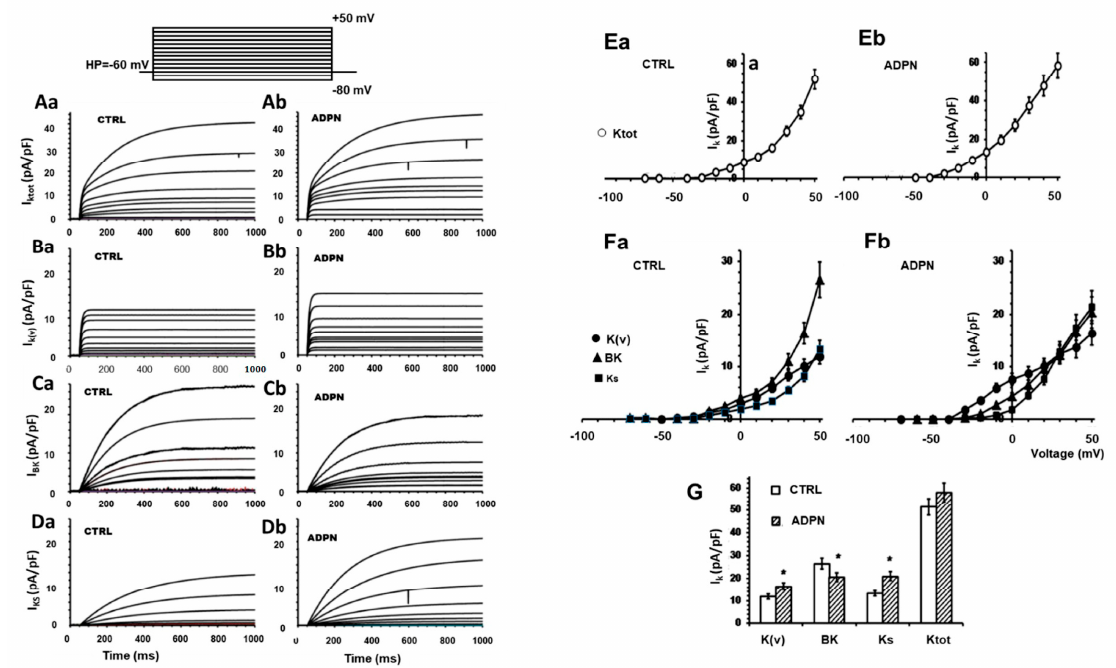
Figure 3. E ff ects of ADPN on the di ff erent voltage-dependent K + currents in an SMC from the gastric fundus. ( Aa , Ab )Total outward K + currents traces, elicited by voltage steps from − 80 to + 50 mV (holding potential (HP) = -60 mV) in nifedipine (10 µ M) containing solution, in control condition ( Aa ), and in the presence of ADPN 20 nM ( Ab ). Current values are normalized to cell capacitance. The pharmacological dissection allowed us to systematically distinguish three kinds of K + currents: IKv ( Ba , Bb ); IBK ( Ca , Cb ); and IKs ( Da , Db ). Current values are normalized to cell capacitance. ( Ea , Eb ) I–V plots related to IK,TOT in CTRL ( Ea ) and in the presence of ADPN ( Eb ). ( Fa , Eb ) I–V plots related to IKV, IBK, and IKs, in CTRL conditions ( Fa ) and in the presence of ADPN (Fb). The continuous lines through the experimental data represent the fitted Boltzmann function. Current values are normalized to cell capacitance. Statistical significance is not depicted in the figure for clarity. ( G ) Bar charts representing the amplitude of K + current for IK,TOT, IKV, IBK, and IKs, in CTRL conditions and in the presence of ADPN. Comparison of the maximal current values recorded at + 50 mV; * p < 0.05 of ADPN vs. CTRL. All of the data are mean values ± SEM. In each experimental condition, data are from CTRL n = 30 cells, ADPN n = 9 cells (5 mice).